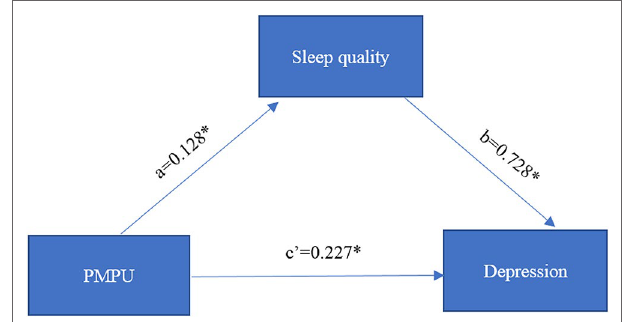
FIgURE 1 | The estimated coefficients of mediation effects of sleep quality on problematic mobile phone use (PMPU) and depression. * p < 0.05.